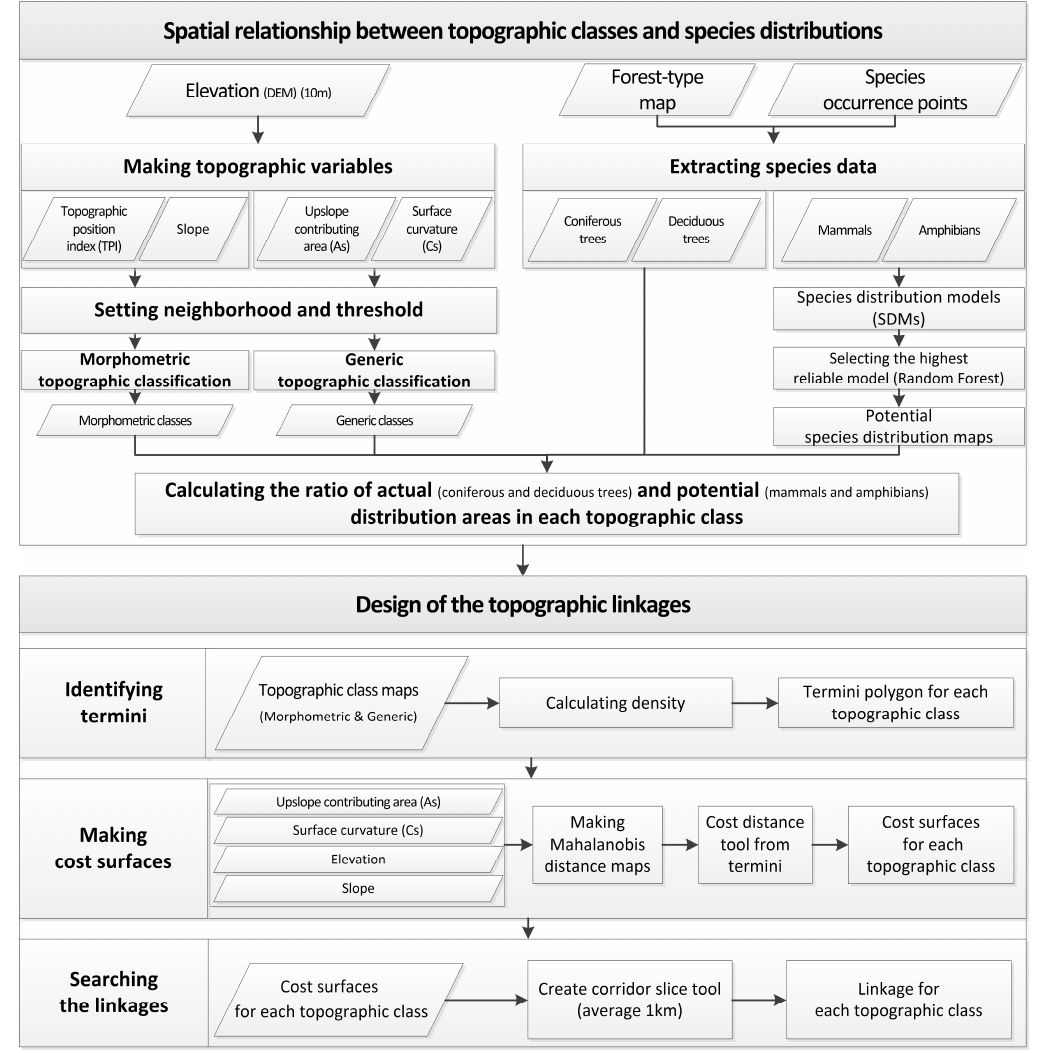
Figure 2. Flowchart of the present study.